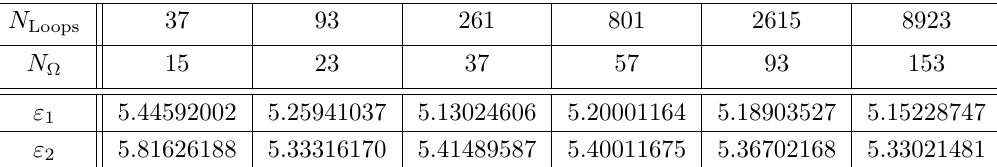
Table 10. The two lowest lying states for k = g 3 = 0 and g 4 = 10